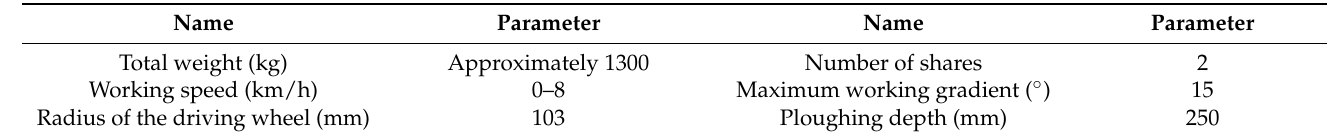
Table 2. Main technical parameters of the hillside crawler tractor.